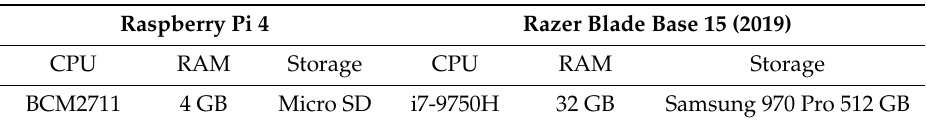
Table 5. System specifications.